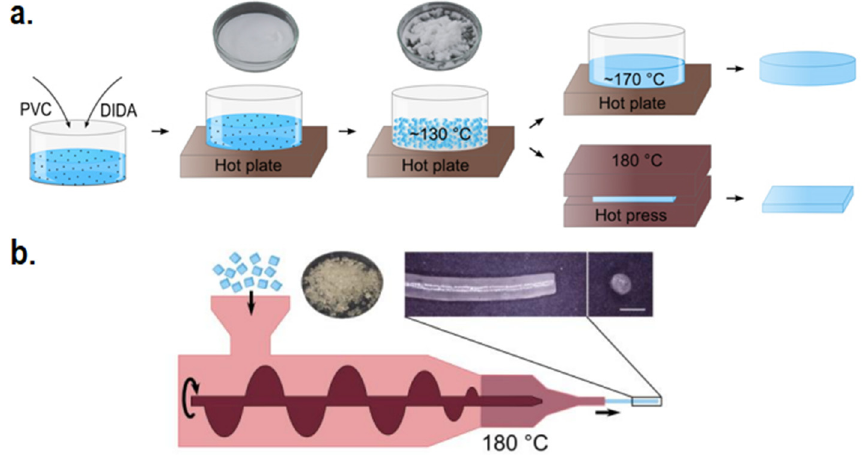
Figure 12. ( a ) Manufacturing route of PVC-DIDA electroactive thermoplastic gel. Heating at ~130 °C accelerates the speed in which the plasticizer is absorbed by the PVC, turning the plastisol into wet crumbly paste; ( b ) Extrusion scheme of PVC-DIDA gel. Adapted with permission from [218]. Copyright (2019) IOP Publishing.